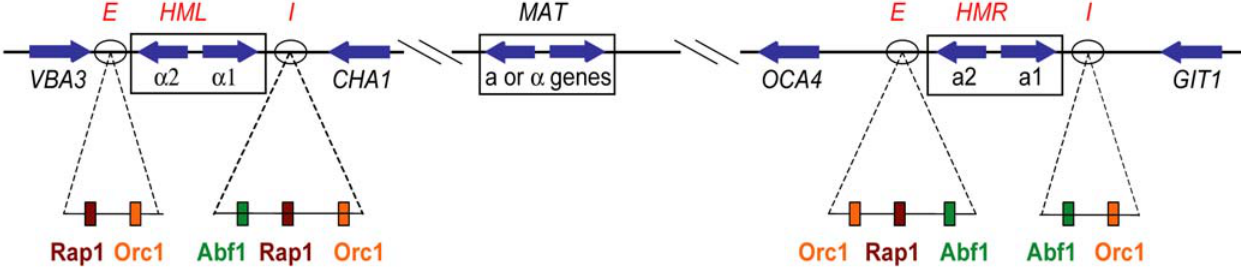
Figure 1. Chromosome III mating loci. MAT and the cryptic mating loci on chromosome III of S. cerevisiae . The genes in the mating loci, HML - and HMR -neighboring genes, the E and I silencers, and the binding sites for ORC, Rap1, and Abf1 in the silencers are shown. The boxes around the mating- type genes represent the sequences shared between the MAT and the HML and HMR loci. The Saccharomyces cerevisiae genome feature coordinates are in Table S2.